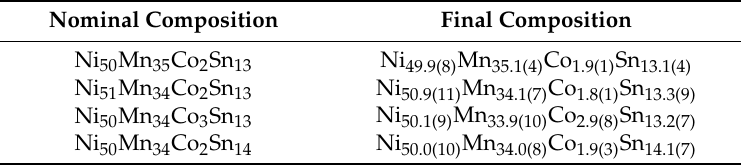
Table 1. Comparison of nominal composition and final composition. The deviation is shown in the